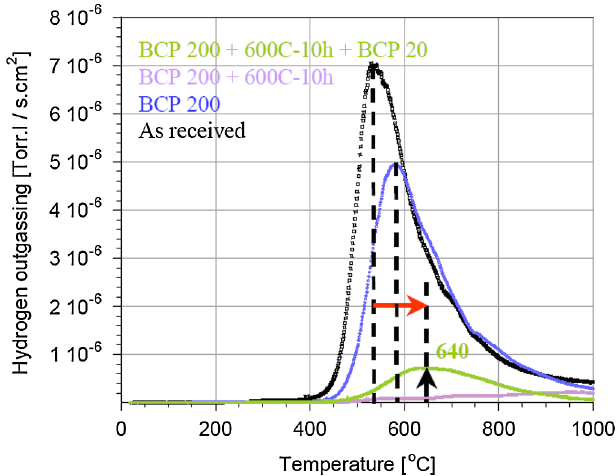
FIG. 6. (Color) Hydrogen outgassing vs temperature measured on Nb samples ( RRR (cid:3) 590 ) after various treatments. The black curve refers to the ‘‘as received’’ sample, the blue curve is after 200 (cid:3) m removal by BCP, the magenta curve is after additional vacuum heat treatment at 600 (cid:1) C for 10 h, and the green curve is after additional 20 (cid:3) m removal by BCP. The figure is taken from Ref. [31].